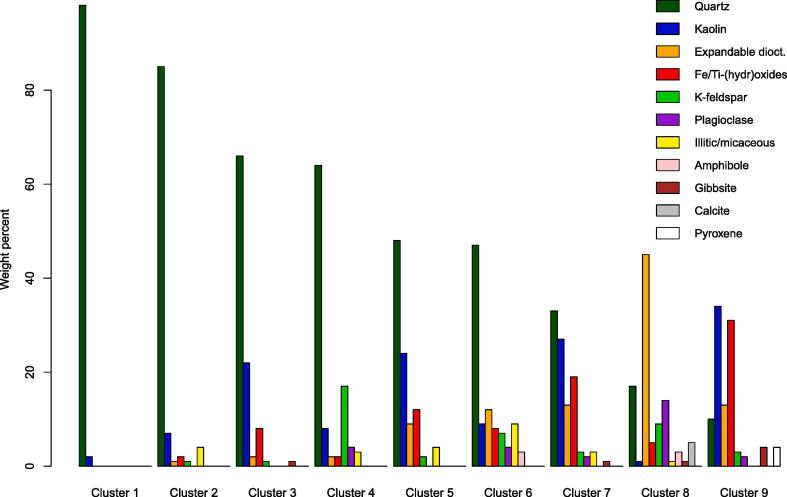
Simplified mineralogy of each cluster, with Fe/Ti-(hydr)oxides grouped together. The Fe/Ti-(hydr)oxide bar therefore represents the sum of goethite, maghemite, ilmenite, hematite and magnetite. A more detailed summary is provided in Table 2.